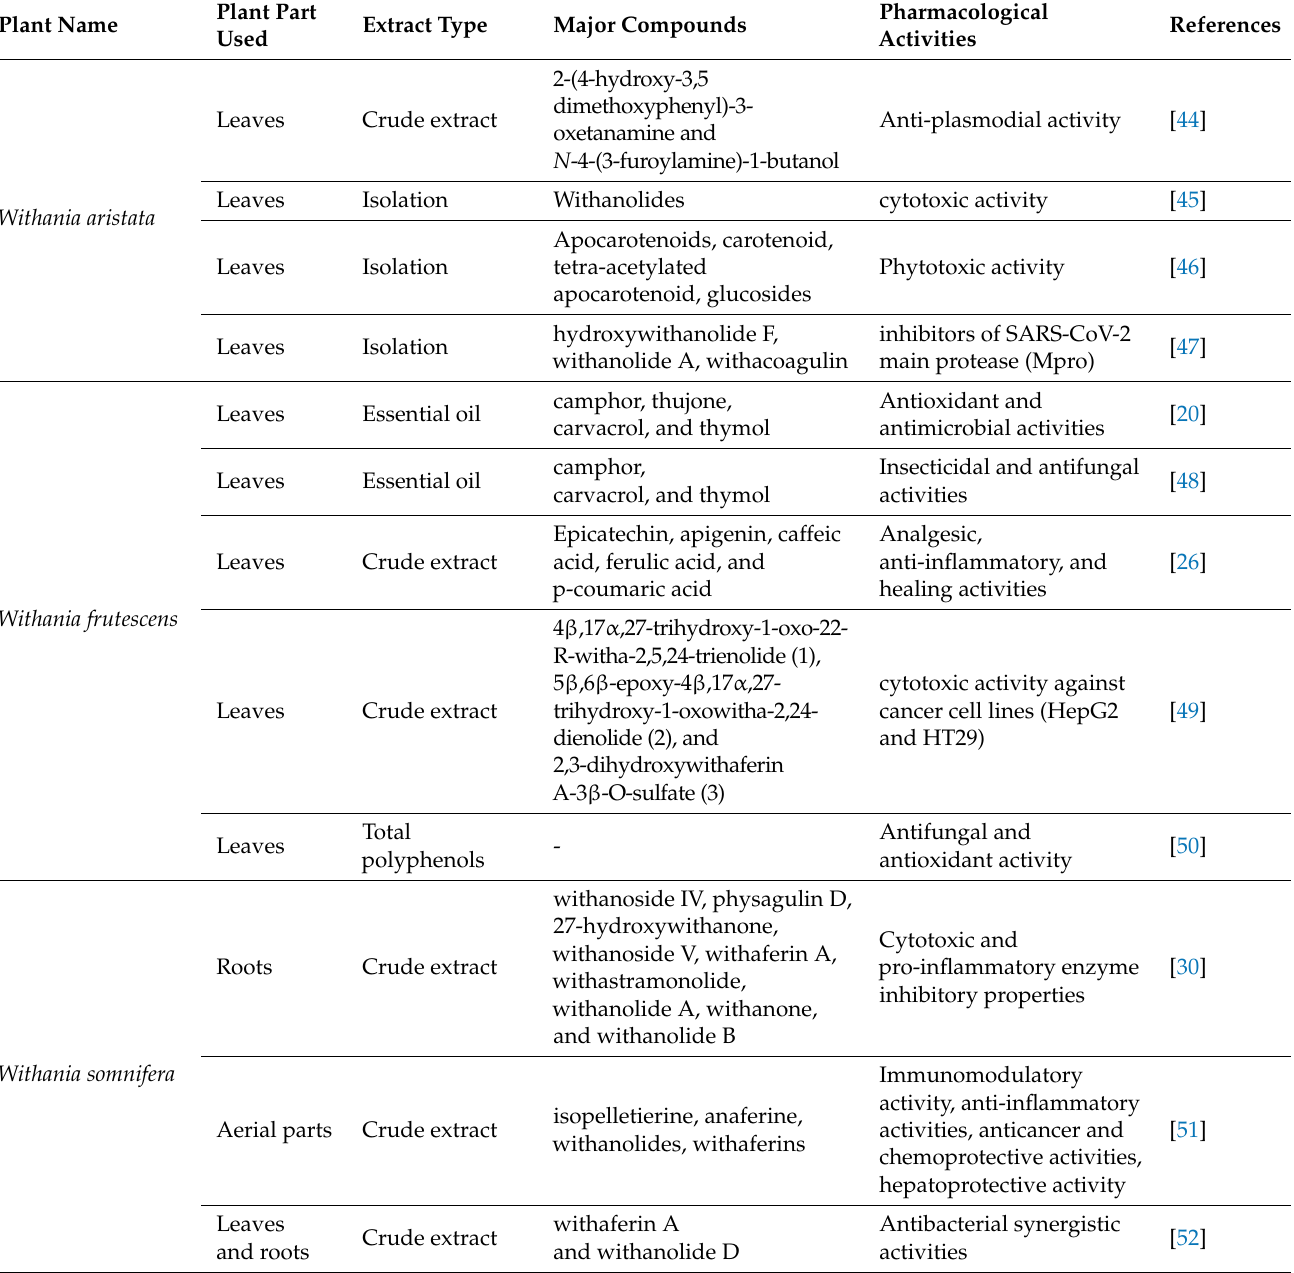
Table 2. Phytochemicals and pharmacological activities of the genus